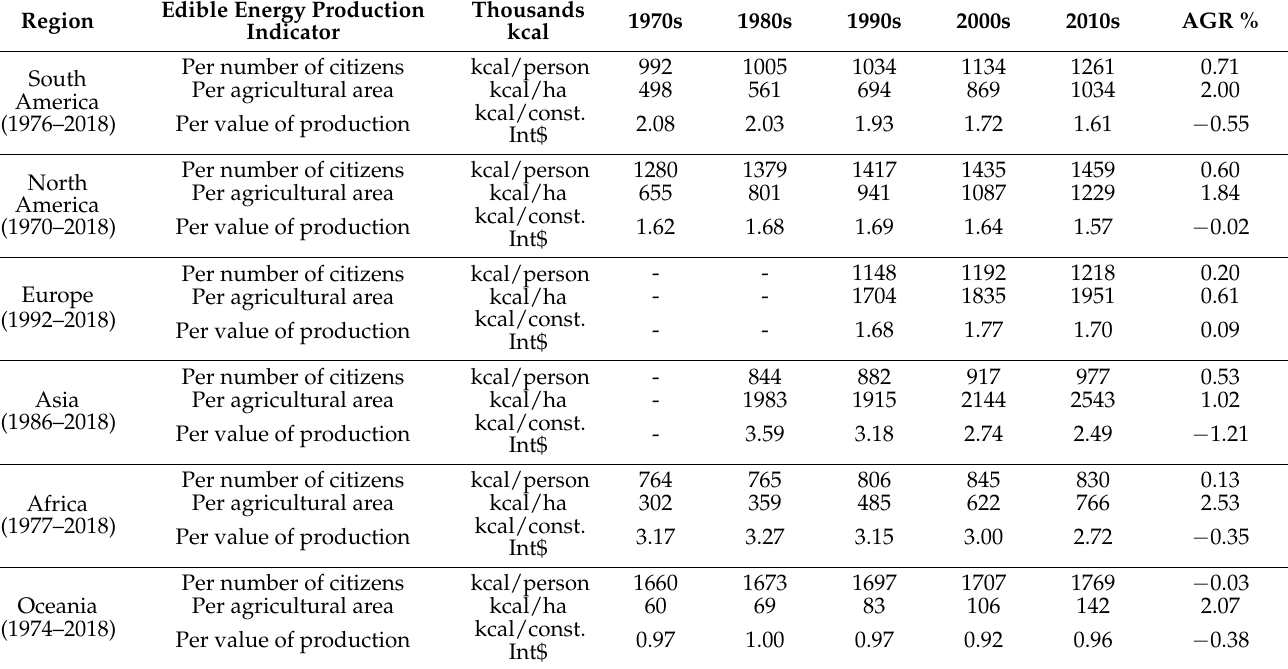
Table 3. Edible energy production in agriculture for years